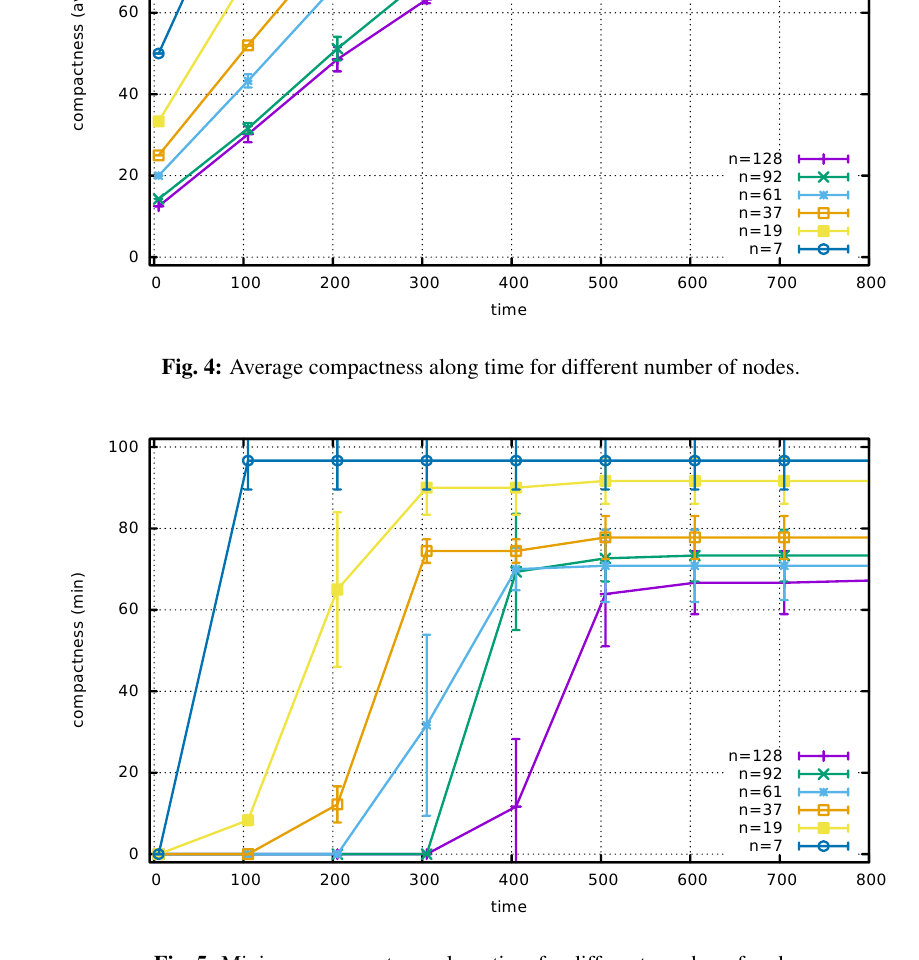
Fig. 5: Minimum compactness along time for different number of